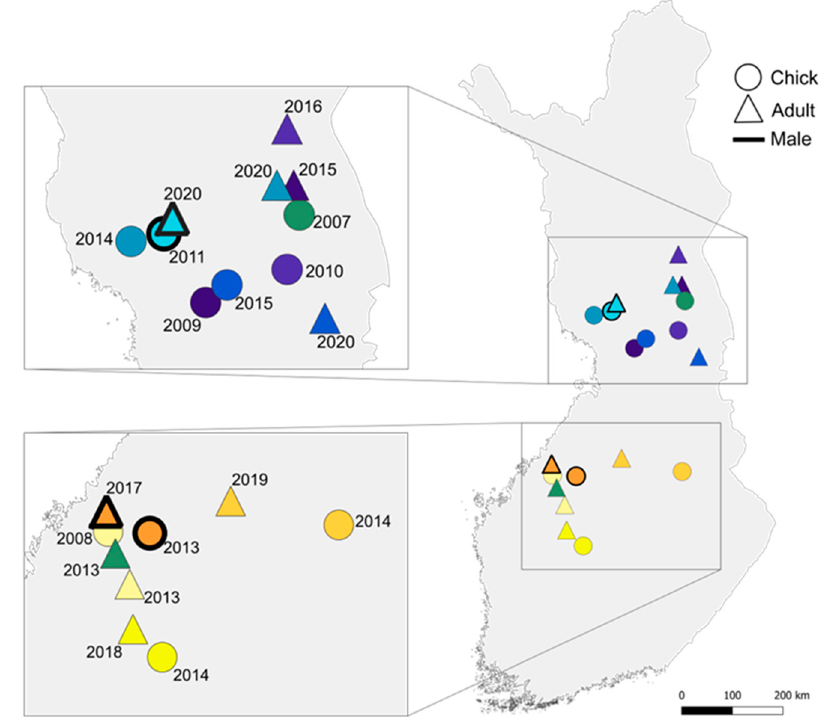
Figure 5. Locations of ten golden eagle chick samples (circles) that were later identified as adults (triangles) using 11 microsatellite loci. Each individual has a unique color code, which is maintained for chick and adult ages. Years of sampling are indicated near the sampling points. The two males are indicated by symbols with a bold outline. Individuals from the northern group are represented by blue color shades, and from the southern group by yellow color shades. One individual that was born in Northern Finland and later was breeding in Southern Finland is colored in green.